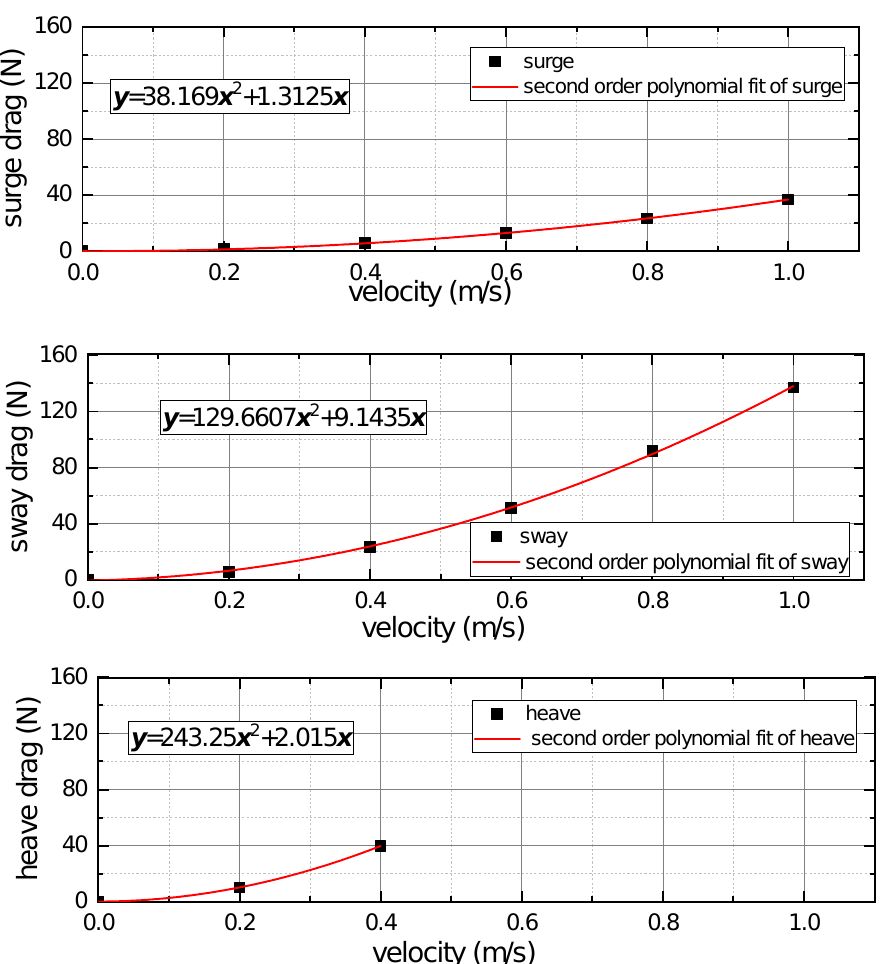
Figure 15. Surge, sway and heave drag force under various